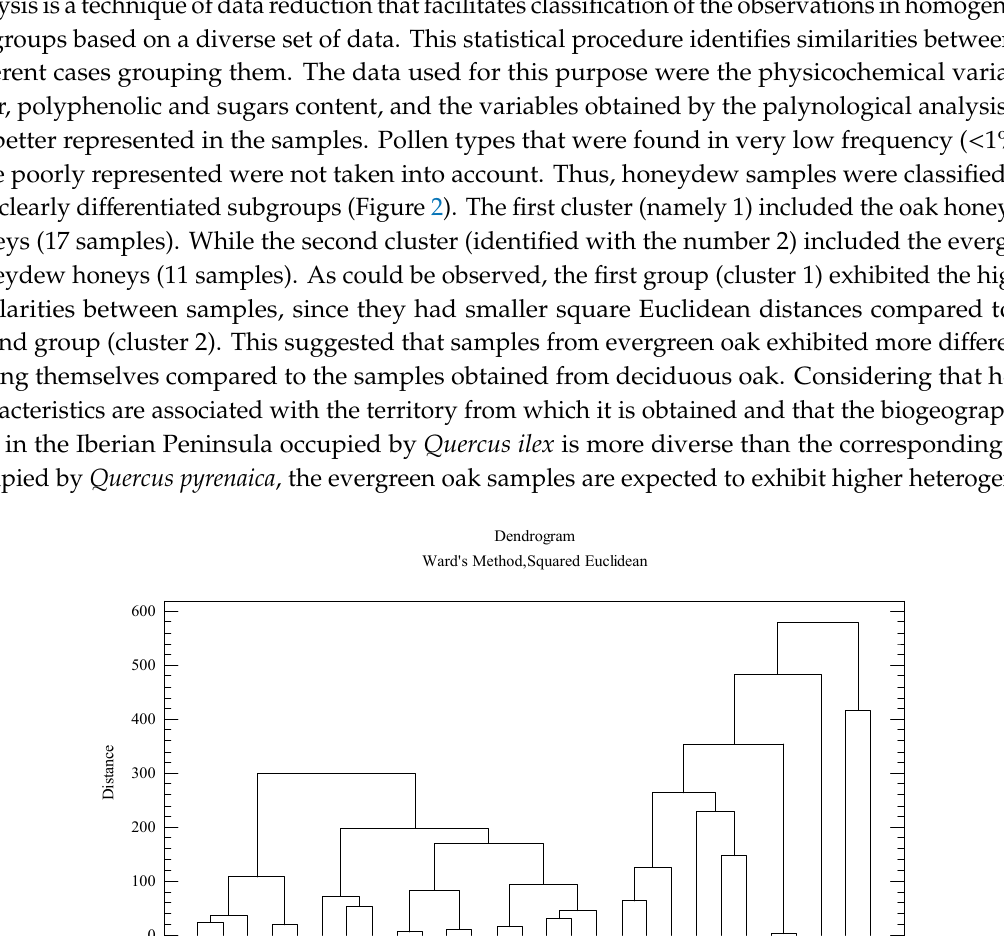
Figure 2. Cluster analysis of the honey samples. 1: oak honeydew. 2: evergreen oak honeydew.